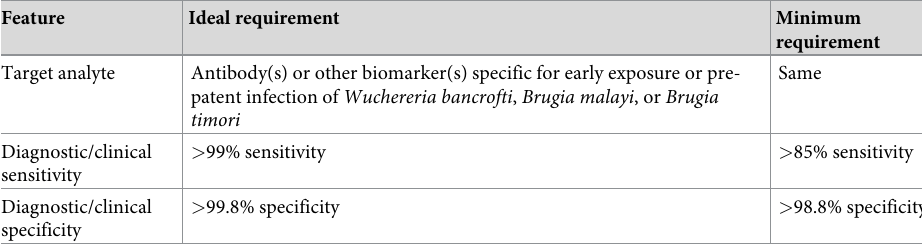
Table 4. Select characteristics of needed test for surveillance of lymphatic